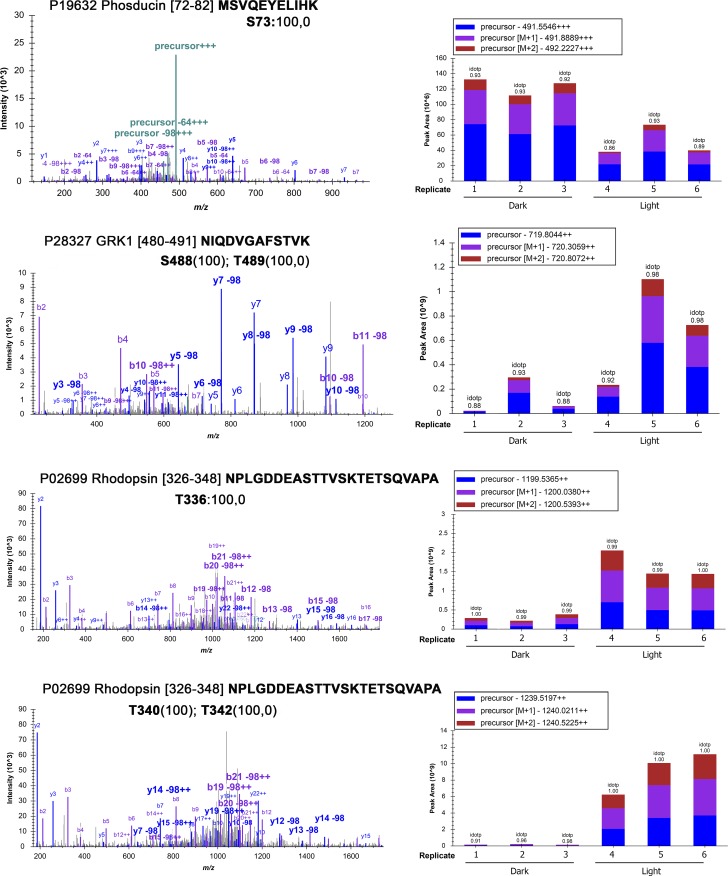
Dark/light fold-change of peak areas from control phosphopeptides from phosducin, GRK1 and rhodopsin shown as a quality control of the phosphoproteomic analysis.Mass spectra of phosphorylated peptides of: phosducin 72–82 peptide MSVQEYELIHK [Uniprot F1MSE1]; GRK1 480–491 peptide NIQDVGAFSTVK [Uniprot P28327]; and rhodopsin 326–348 peptide NPLGDDEASTTVSKTETSQVAPA [Uniprot P02699]. For each peptide, the peak area of the precursor peptide ion was extracted and plotted for each sample. Samples 1–3 are dark-adapted retinas; 4–6 light-exposed retinas (biological replicates). Light/dark log2 fold-change values were: phosducin S73 (−1.39; p=0.01); GRK1 S488/T489 (2.70; p=0.08); Rhodopsin T336 (2.49; p=0); and Rhodopsin T340/T342 (5.53; p=0).